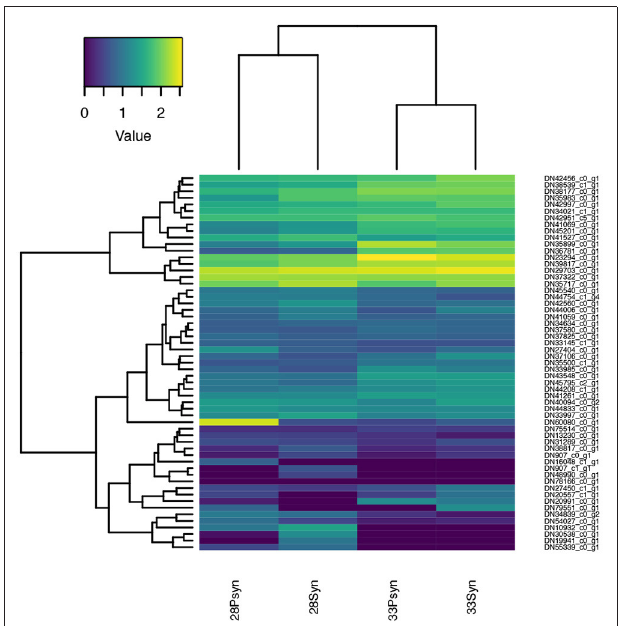
FIGURE 12 | Heatmap of normalized expression for genes annotated with the SMART hox domain (SM00389). There are five regions within the heatmap relevant to synarcual development (A–E) . Although chondrichthyans were previously thought to lack HoxC genes, a Hoxc6 -like, and a Hoxc9 -like are expressed, in addition to a large number of other Hox